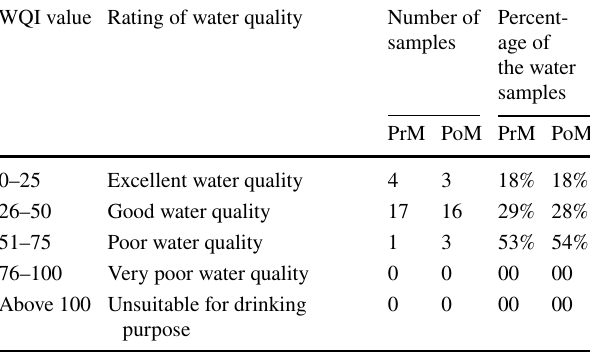
Table 8 Water quality classification based on WQI